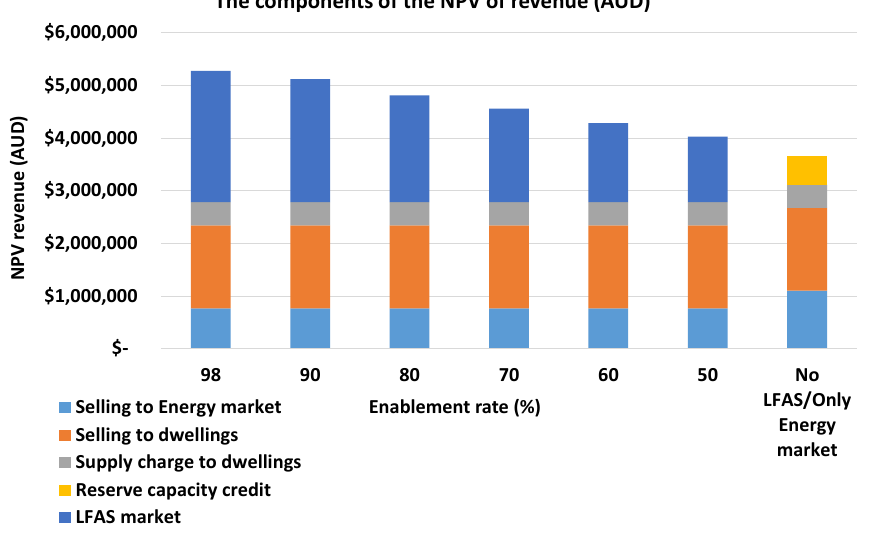
Figure 10. The components of the NPV of revenue with and without participation in LFAS market.